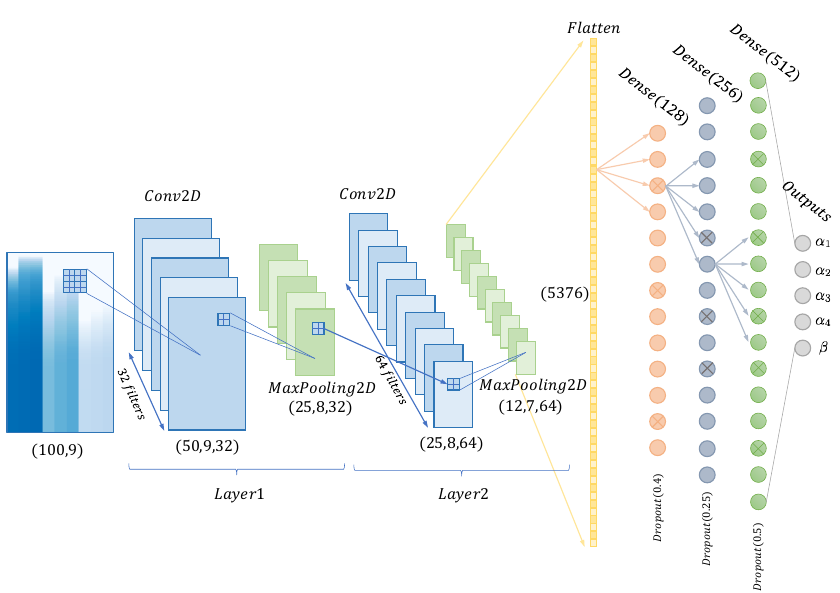
Figure 6. Sketch of the convolutional neural network (CNN) used in this